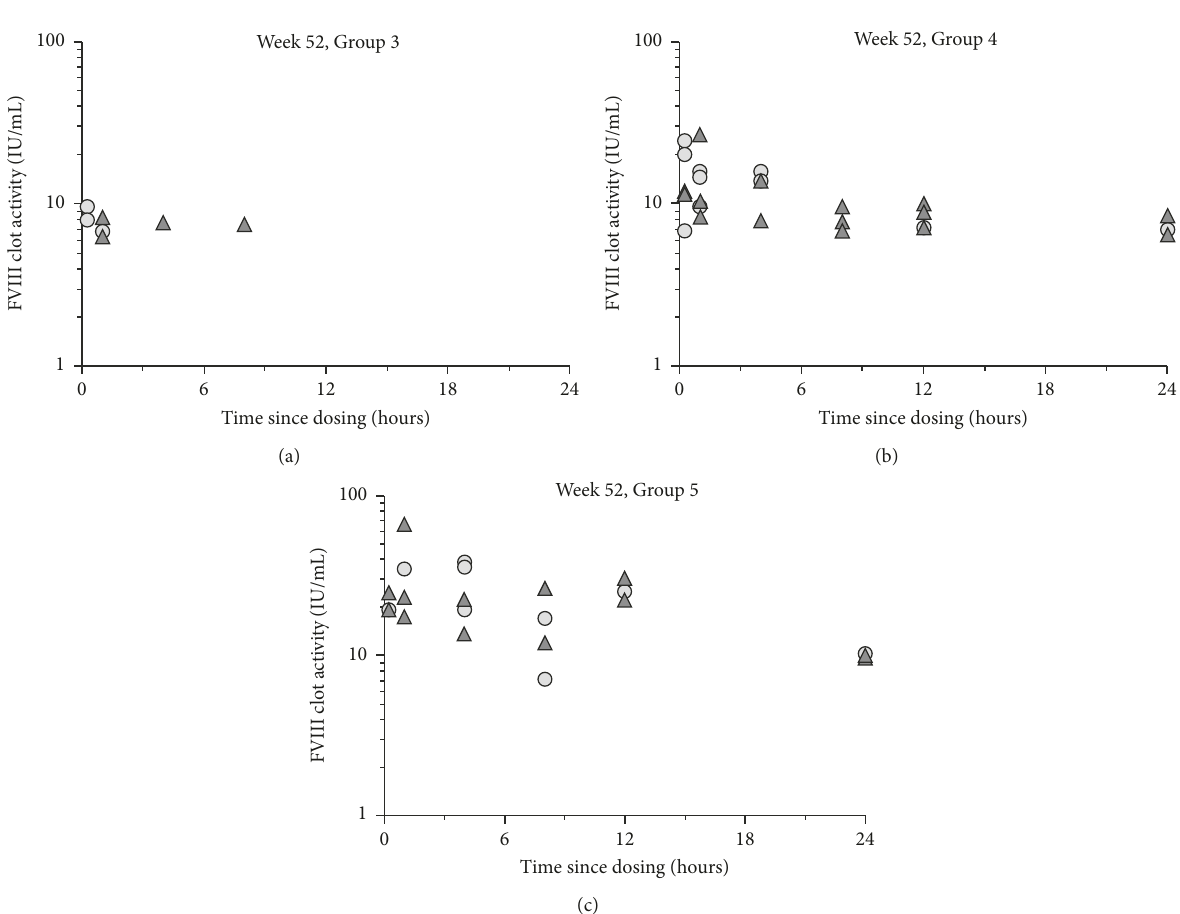
Figure 1: Individual FVIII clotting activity versus time in week 52 in male (triangles) and female (circles) Rowett nude rats following an intravenous dose of 150 IU/kg (Group 3), 500 IU/kg (Group 4), or 1200 IU/kg (Group 5) (sparse sampling with two samples per animal, in general n = 2-3 per sex per time